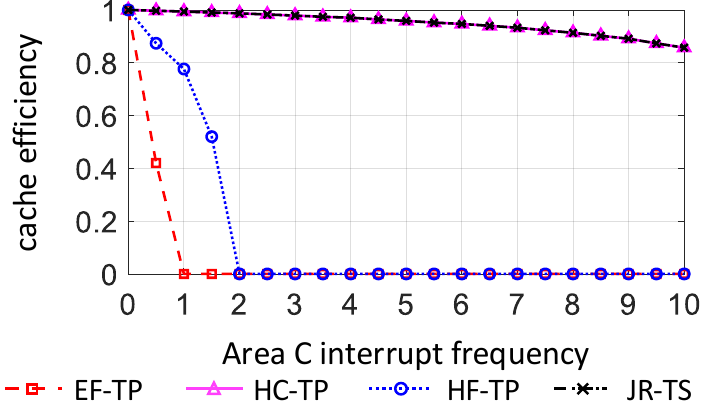
Figure 15. Cache efficiency in heterogeneous IoV test